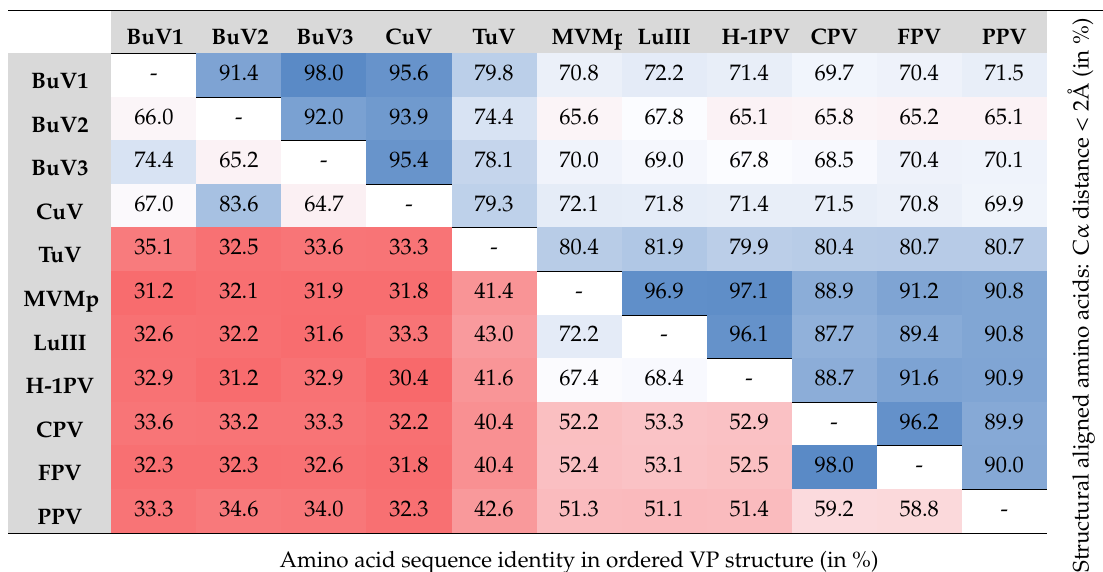
Table 3. Protoparvovirus sequence (%, bottom left) and structural (%, top right) identity